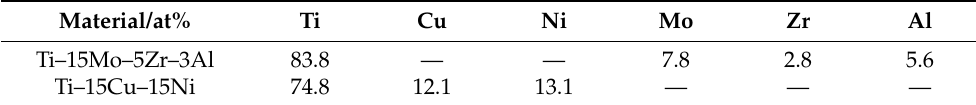
Table 1. Nominal compositions in at% of Ti–15Mo–5Zr–3Al and Ti–15Cu–15Ni.